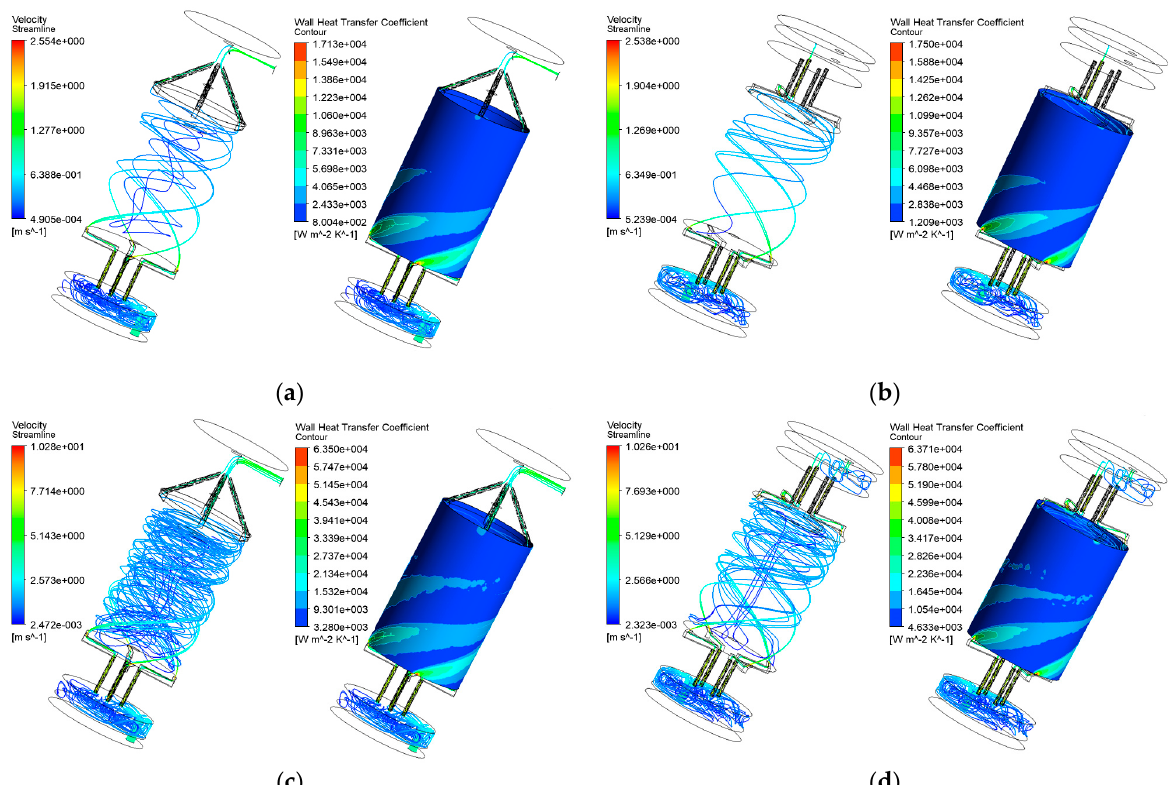
Figure 6. Simulation in CFX between asymmetric and symmetric structures under different velocities: ( a ) asymmetric-1 m/s; ( b ) symmetric-1 m/s; ( c ) asymmetric-4 m/s; ( d ) symmetric-4 m/s.